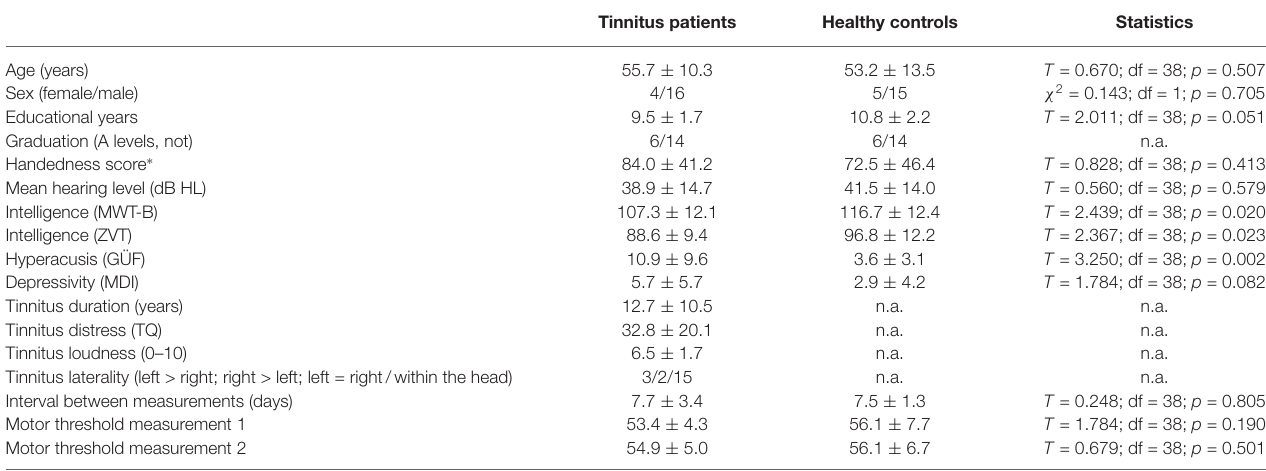
TABLE 1 | Demographic, tinnitus-related, and measurement-related data of the patient and control